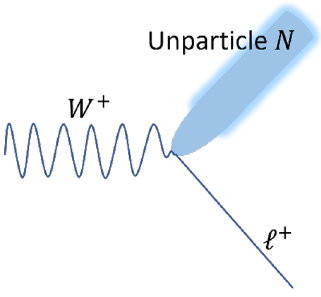
Figure 4 . Unparticle production from W boson